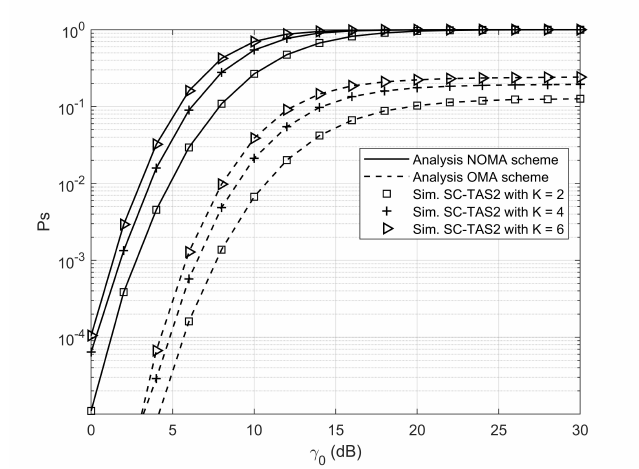
Figure 4. Impacts of the number of antennas K on Ps of SC-TAS2